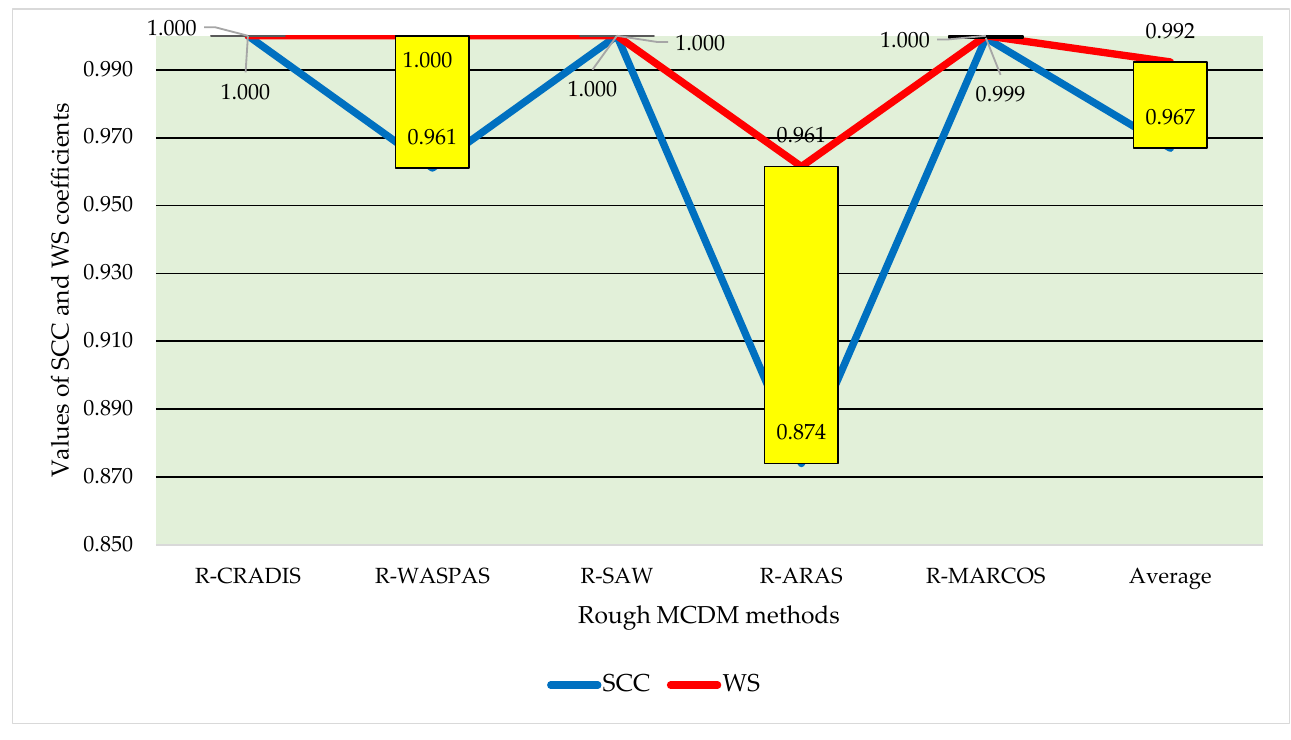
Figure 7. Correlation of ranks in comparative analysis. Rough CRADIS has a full correlation of ranks with Rough SAW, while it has 0.999 with Rough MARCOS, 0.874 with Rough ARAS, and 0.961 with Rough WASPAS when it comes to the SCC coefficient. The situation is similar with the WS coefficient, which has a full correlation with R-WASPAS, R-SAW, R-MARCOS.